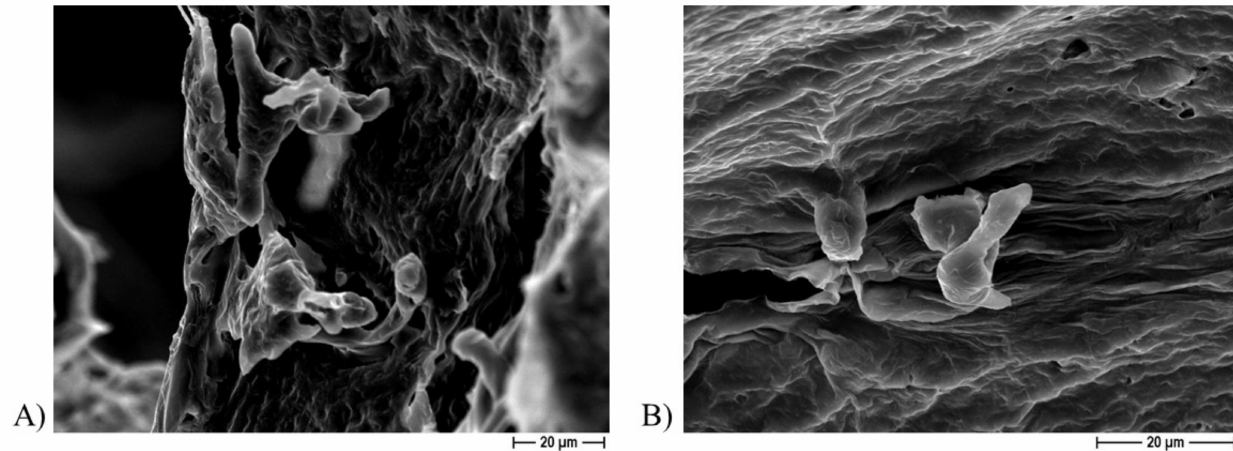
Figure 10. Representative FESEM micrographs of PCL scaffolds obtained by using NaCl salt as template showing presence of Saos-2 cells present at 1000 × magnification after 7 days ( A ) and at 1500 × magnification after 14 days ( B ) of incubation.